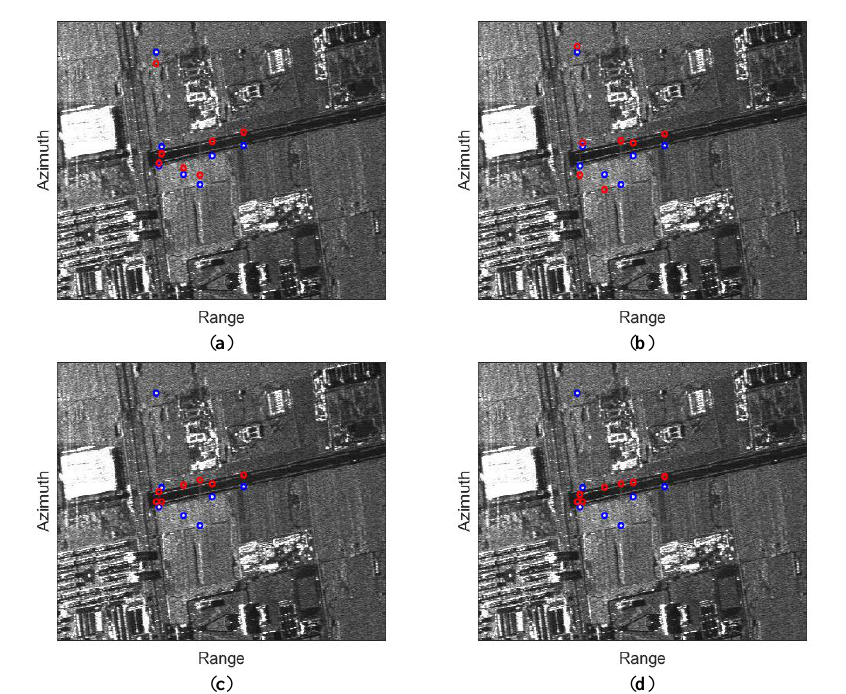
Figure 19. Relocation results for different methods. ( a ) AMF. ( b ) SP. ( c ) WAMF. ( d )